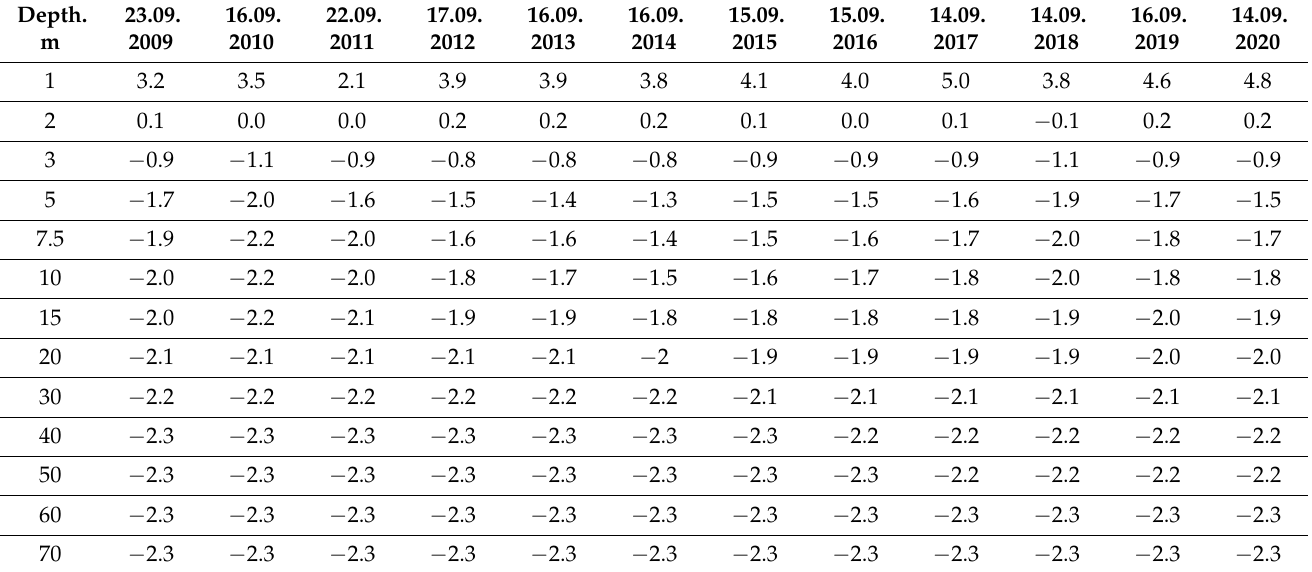
Figure 11. Long-term variability in the mean annual ground temperature at a depth of 10 m and the trends of its increase in the experimental plots of the Tuymaada Station. Table 5. Ground temperature in the meadow at the Tuymaada Station (°C).